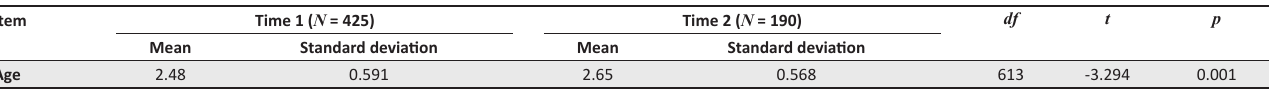
TABLE 5: Independent samples test for differences in age of the participants at the two time